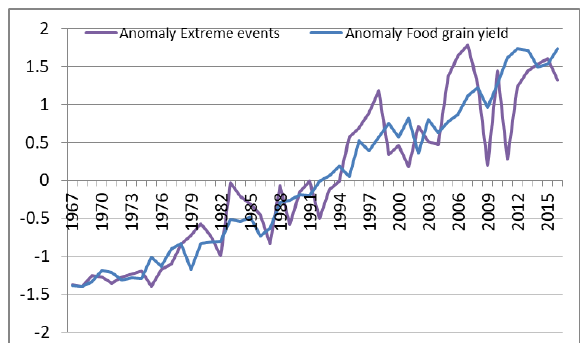
Figure 4. Anomaly of extreme events vis-à-vis anomaly of food grain yield